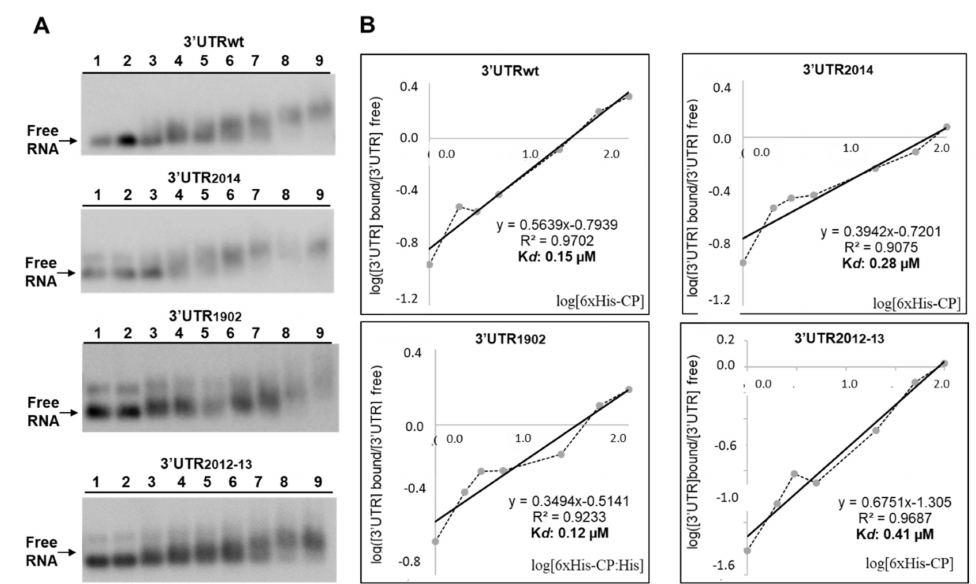
Figure 3. Analysis of RNA–protein complexes, formed between purified 6xHis-CP protein and the WT and mutated versions of the 3 (cid:48) UTR transcript of AMV-RNA. ( A ): Example of an EMSA after incubation with 5 ng of 3 (cid:48) UTRs transcript wt, or the indicated mutant without protein (lanes 1 and 2), or with 1, 2, 3, 5, 20, 50 and 100 ng of 6xHis-CP (lanes 3 to 9) corresponding to 0.004, 0.008, 0.01, 0.02, 0.08, 0.20 and 0.41 µ M, respectively. ( B ): Representation of Hill transformation of the RNA-CP binding obtained from three independent experiments. R2 coefficient, regression equation and the dissociation constant (K d ) are